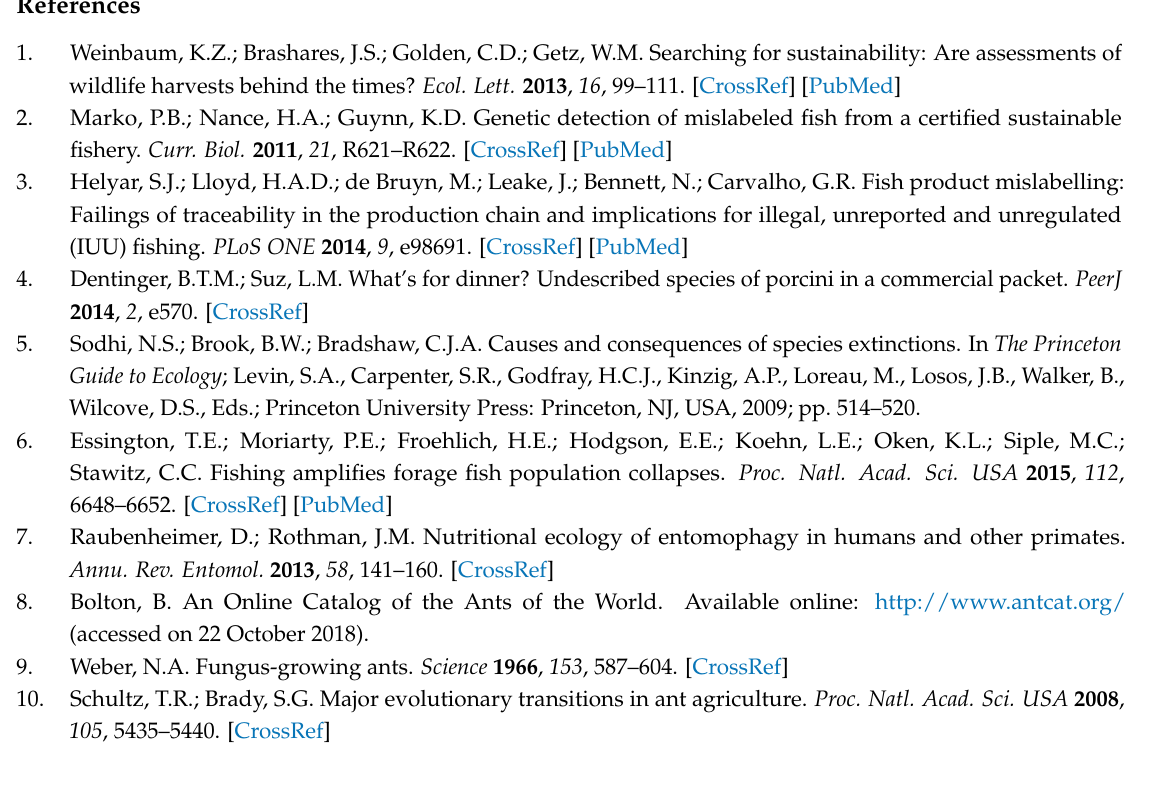
Supplementary Materials: Table S1: List of samples with species ID, sample ID, sample location, GenBank accession number and reference (when available), Figure S1: PASTA scores (blue, left y-axis) and SP-Scores (red, right y-axis) generated using FastSP versus the subset size for the subalignments, i.e., maximum sub problem, performed by PASTA. Based on the curves of these graphs and the topologies of the test trees produced by PASTA, we selected the alignment produced by PASTA with a maximum sub problem size of 100, Figure S2: Bayesian tree including branch lengths. Posterior probabilities >0.50 are indicated at each internode, Figure S3: Final PASTA tree estimation, with maximum sub problem size set at 100 and 10 iterations. Local SH-like support values are indicated at each internode, Figure S4: Most likely tree (-Ln likelihood = − 6386.470862) estimated with RAxML. Bootstrap proportions are indicated at each internode, Figure S5: Expanded version (without collapsed branches) of the Bayesian tree shown in Figure 2 including the same box coding to depict internode support and